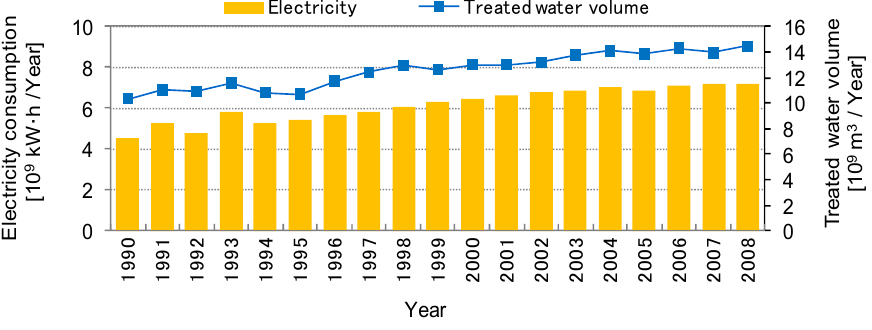
Figure 12. Relationship between energy consumption and treated wastewater volume for sewer systems.